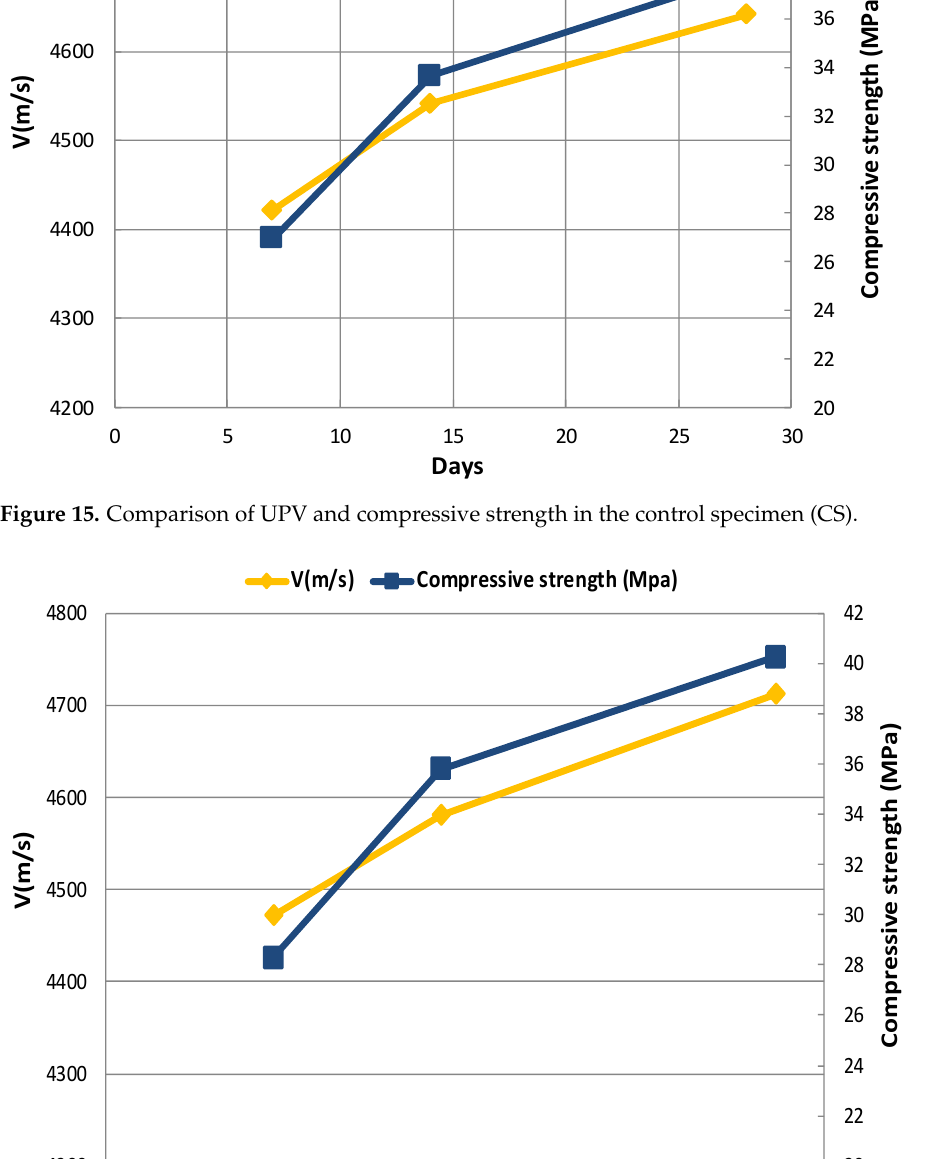
Figure 17. Comparison of UPV and compressive strength at 5% replacement of sand (S-J-S) . 3.6. Relationship between Pulse Transmission Speed and Compressive Strength When UPV is used to characterize the concrete compressive strength, no specific re- lationship can be established between them. However, the elastic modulus of concrete is correlated with the compressive strength. Besides, the UPV is connected with the modulus of elasticity and density of concrete. Thereby, a priori motive to investigate the concrete